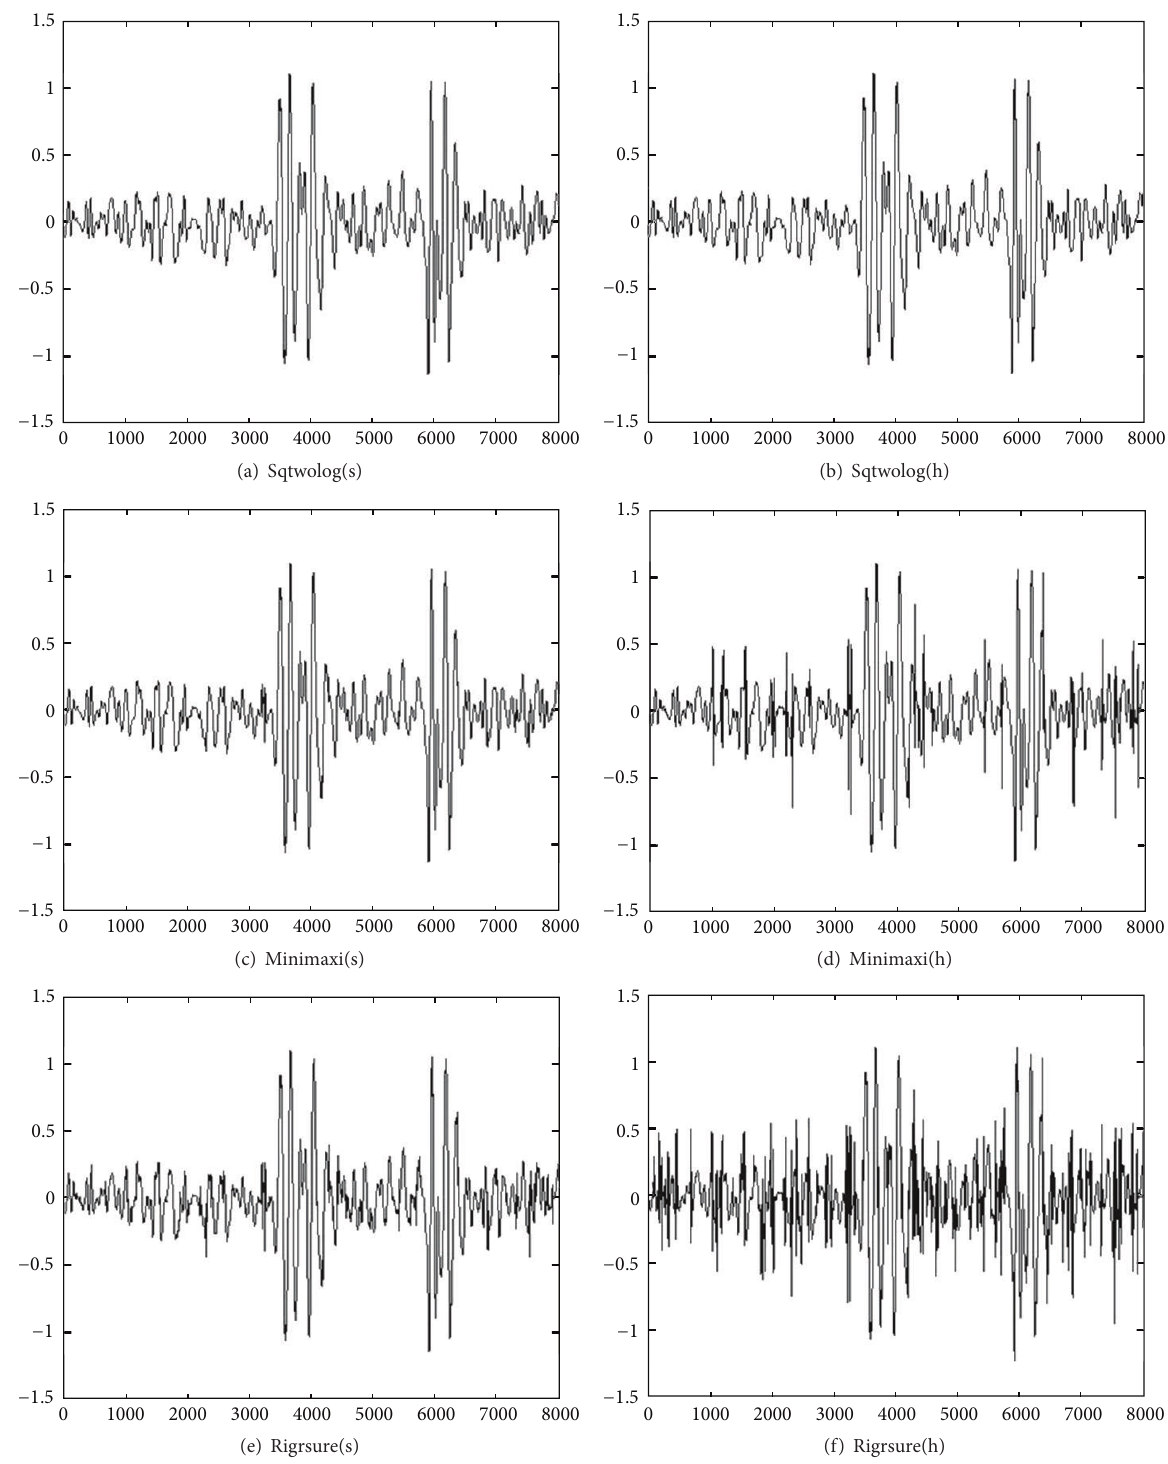
Figure4:DenoisedfPCGsignalusingdifferentalgorithms:(a)sqtwolog(s),(b)sqtwolog(h),(c)minimaxi(s),(d)minimaxi(h),(e)rigrsure(s), and (f)